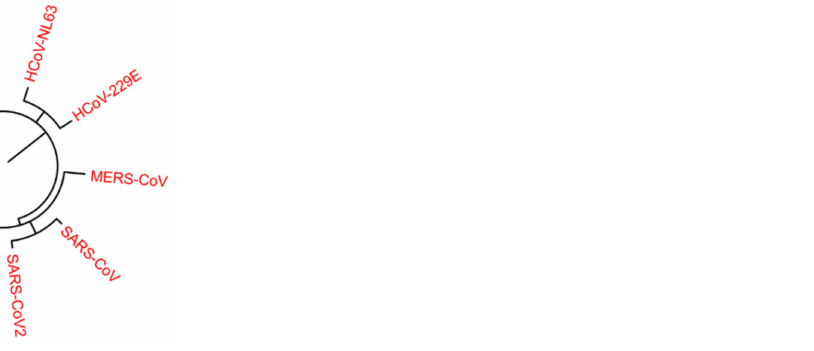
Figure 1. Schematic representation of the taxonomy of Coronaviridae. The species of the α - and β -coronaviruses that infect humans are in red. HCoV: human coronavirus, MERS-CoV: Middle East respiratory syndrome coronavirus, SARS-CoV: severe acute respiratory syndrome